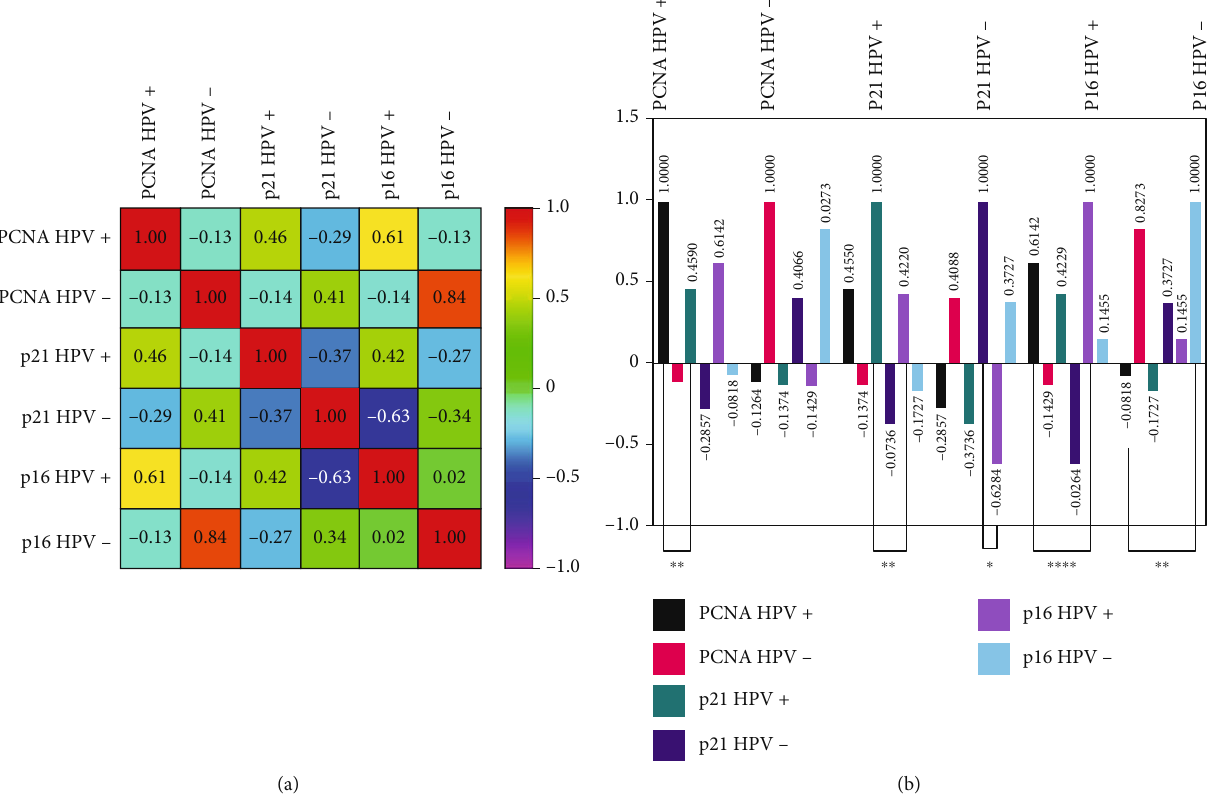
Figure 5: Correlation analysis based in the HPV status in FFPE samples. (a) Heatmap of Spearman ’ s correlation test between p21, p16, and PCNA in HPV+ and HPV- in FFPE samples. The r coe ffi cient is placed inside the cells with a variation from 1 (strongest positive correlation) to -1 (strongest negative correlation). (b) Correlation between p16, p21, and PCNA in HPV+ and HPV- in FFPE samples. Each gene section shows the positive ( r = 1 ) or negative ( r = − 1 ) correlation coe ffi cient in the bar notation of the analyzed target. p value: ∗ < 0.05; ∗∗ < 0.01; ∗∗∗ < 0.001; ∗∗∗∗ < 0.0001.